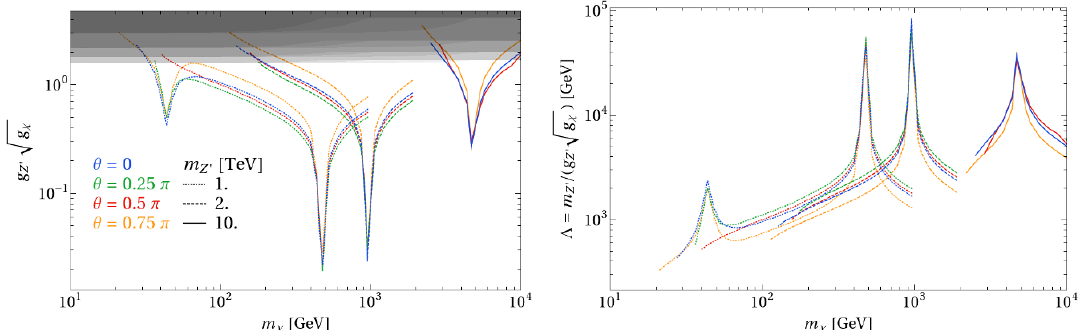
Z 0 ; g (cid:31) and